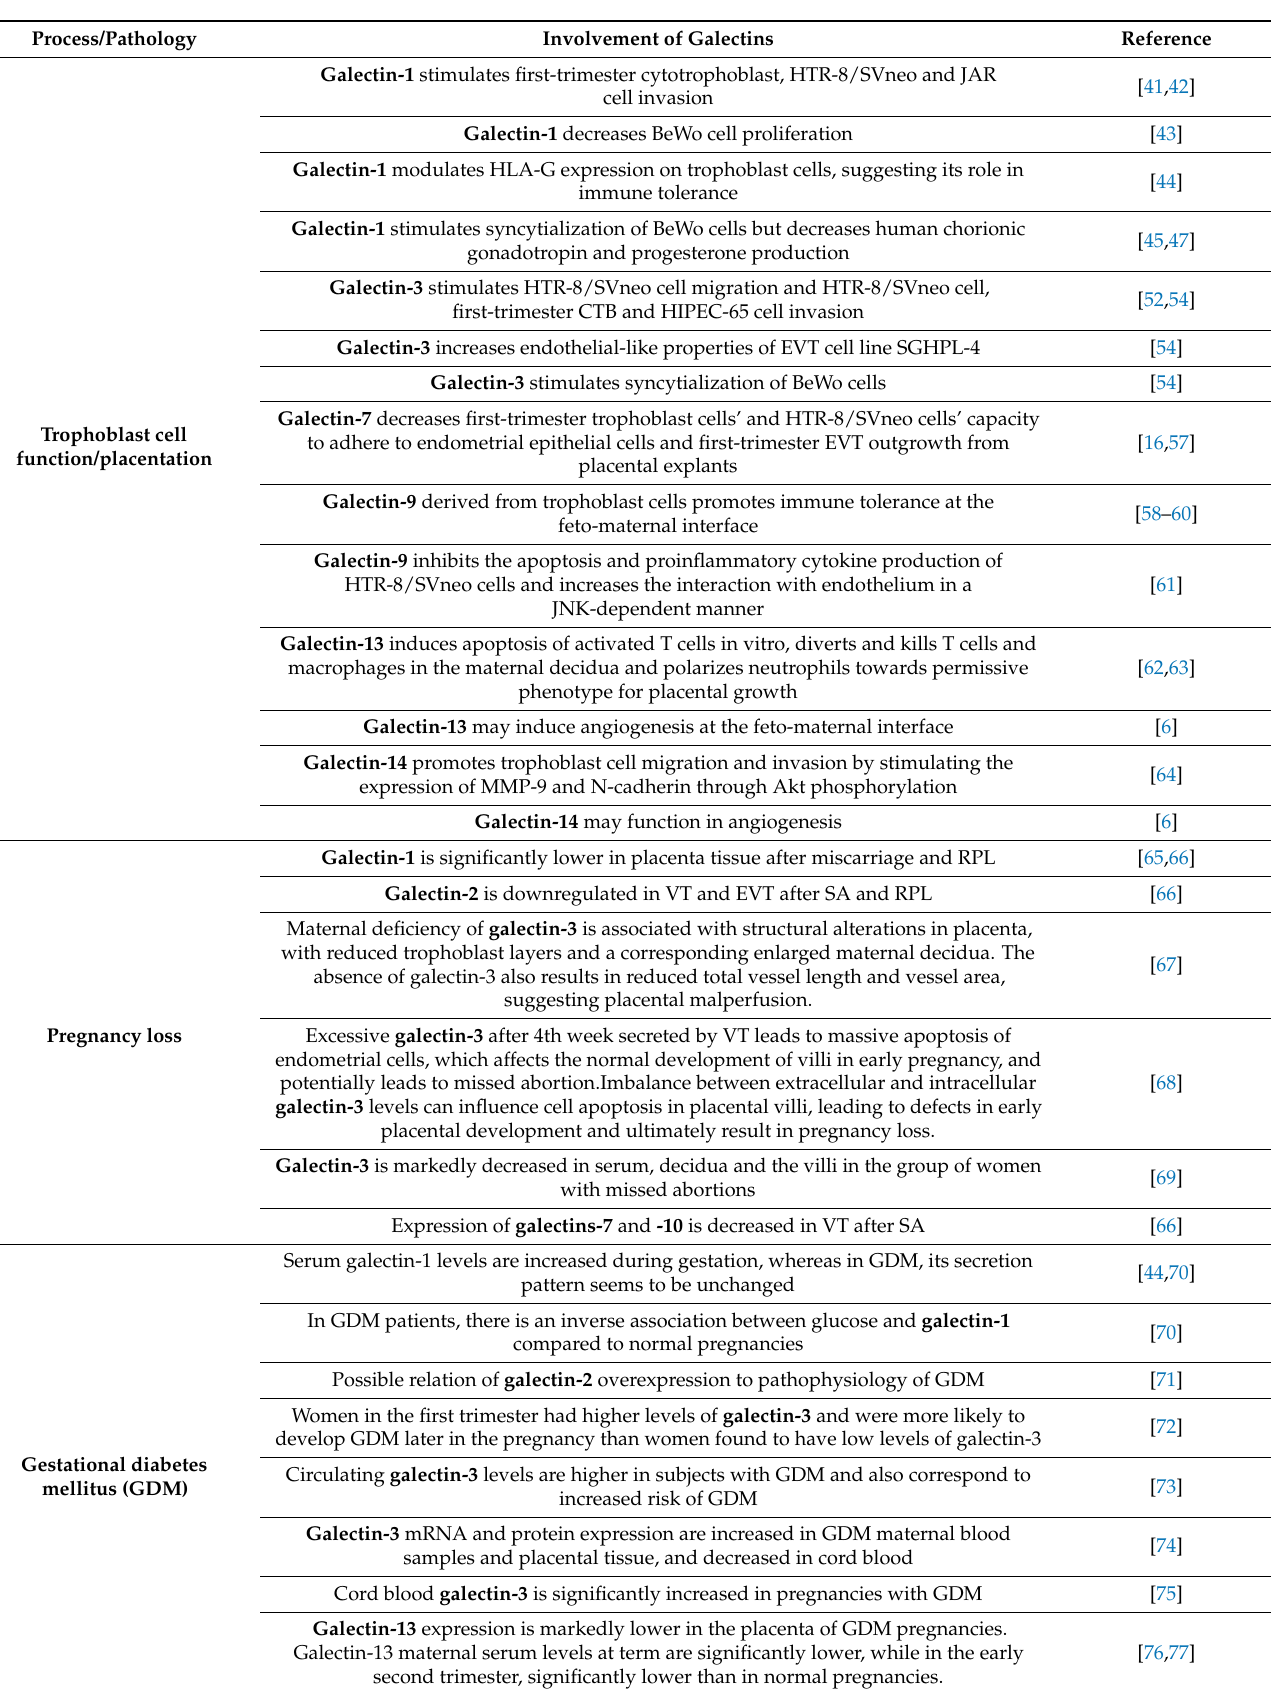
Table 1. Involvement of galectins in pregnancy-related processes and